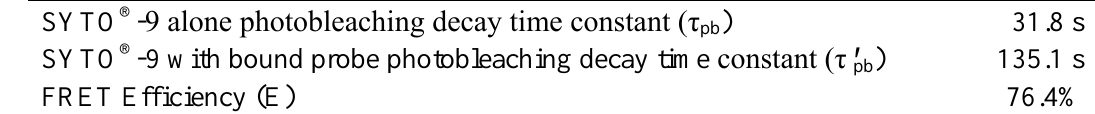
Table 2. FRET-ISH photobleaching decay time constants and FRET